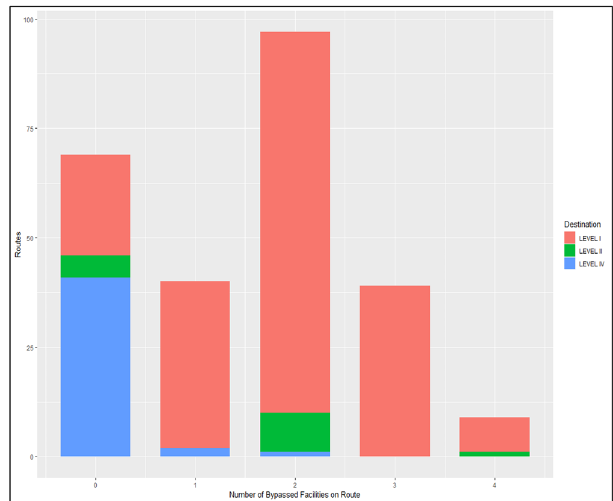
Figure 3. Destination facility level and number of facilities bypassed. Y axis shows number of emergency medical services encounters in the study sample; X axis shows number of facilities bypassed en route to ultimate destination. Shaded bars represent the pediatric capability of the destination